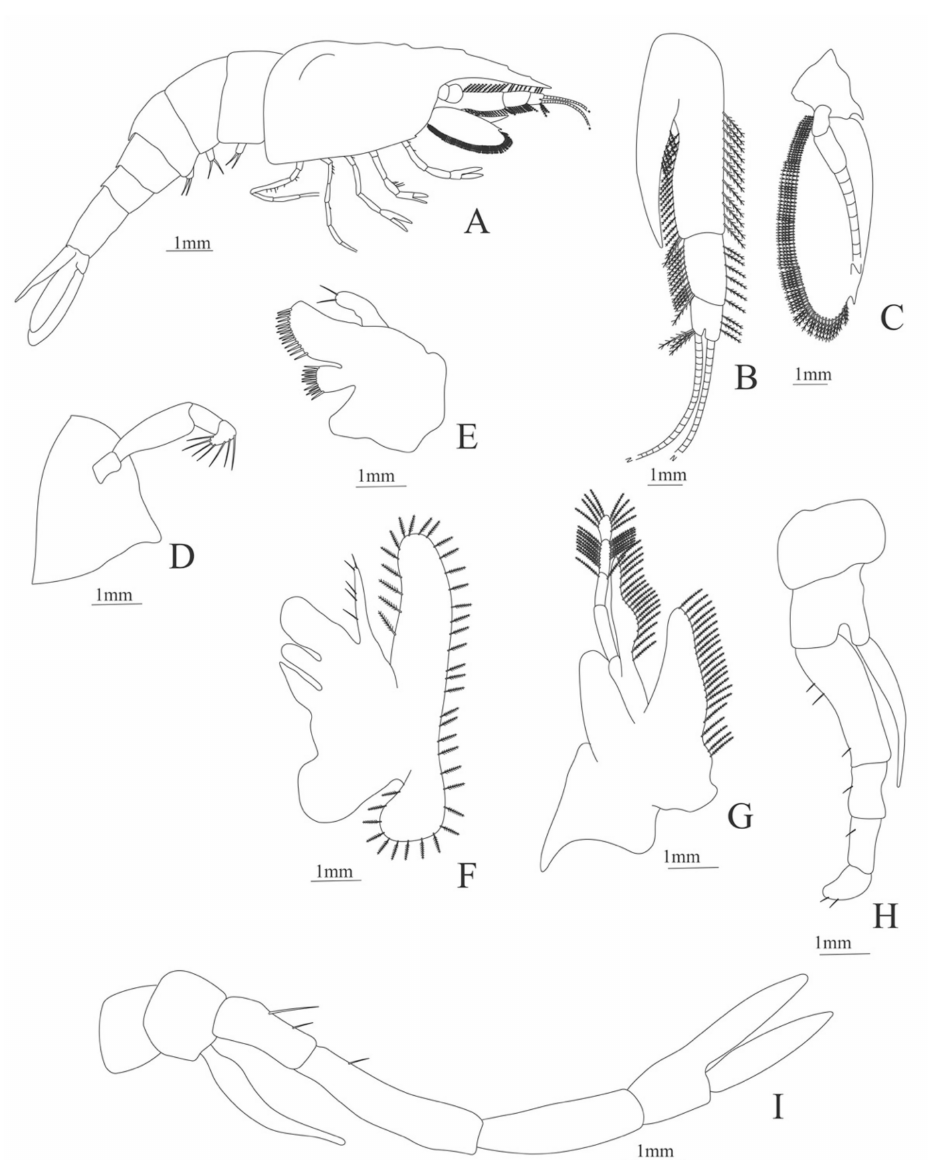
Figure 29. Cerataspis monstrosus : ( A ) lateral view; ( B ) antennule; ( C ) antenna; ( D ) mandible; ( E ) maxillule; ( F ) maxilla; ( G ) first maxilliped; ( H ) second maxilliped; ( I ) first pereopod. Uropod (Figure 30E). Endopod well developed with 96 plumose setae; exopod with 120 plumose setae. Telson (Figure 30F). (Damaged in the specimen) Subrectangular, distal margin bearing row of 13 min spines and 3 pairs of spines on lateral margin, small simple setae between the lateral